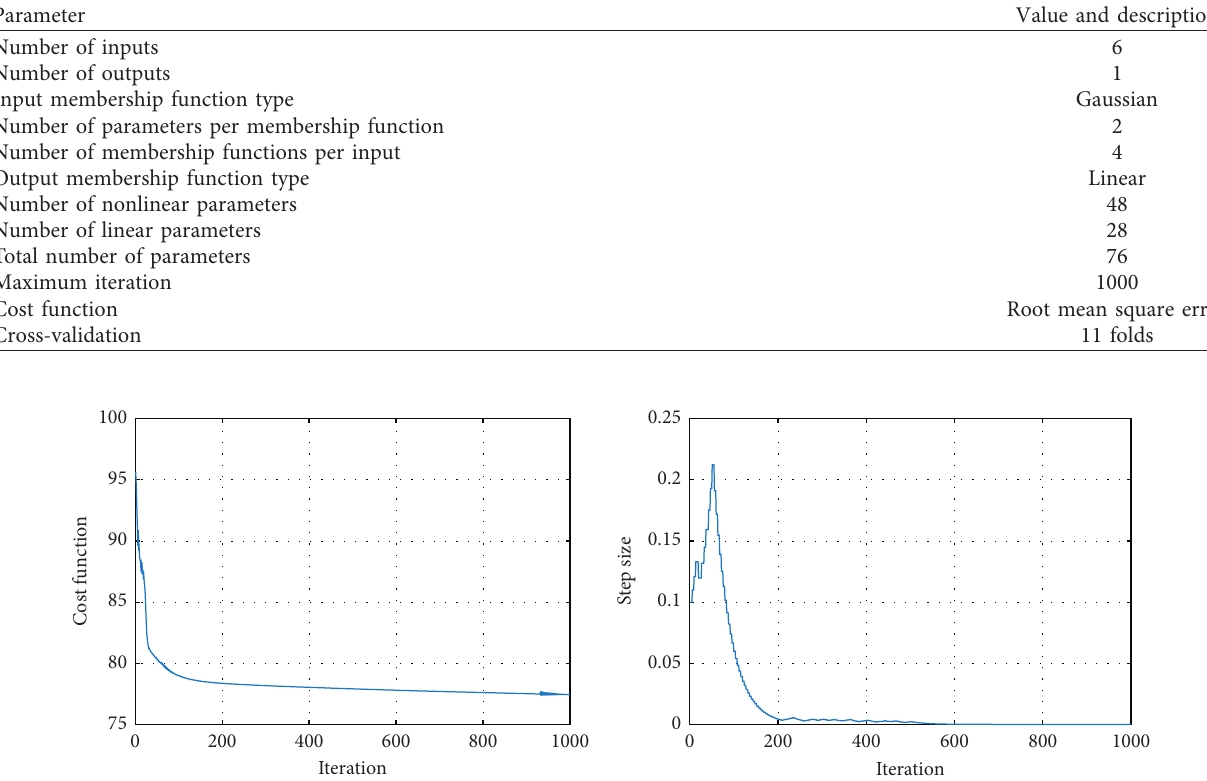
Table 3: Parameters of the ANFIS model.